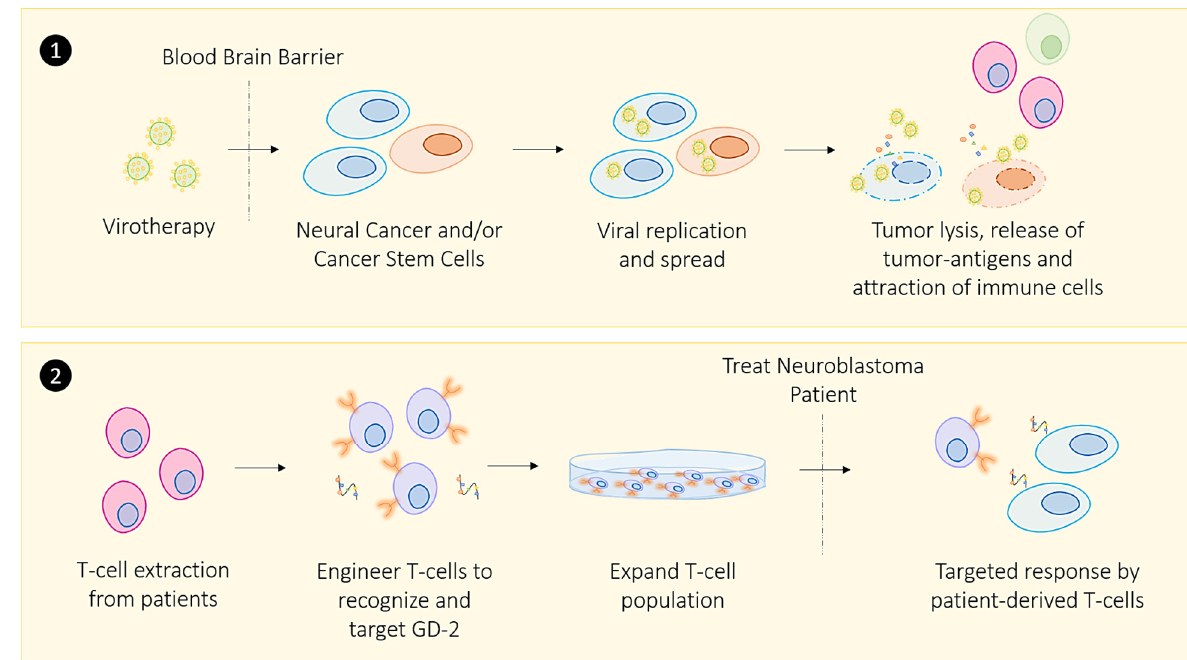
Figure 3. Neuroblastoma as a Study Model. Schematic representation of the virotherapy and targeted T cell therapeutic approach is applied to treat neuroblastoma. (1) Application of Zika virotherapy is engineered to target neural cancer and cancer stem cells to elicit an immune response targeting tumor-associated antigens’ release following virus-mediated cancer cell lysis. (2) Targeted CAR T cell therapy, where patient-derived T cells are engineered to recognize and target antigens exclusively expressed on neural cancer cells (i.e., GD-2) and target and clear cancer cells expressing this marker. Abbreviations: CAR T cells, chimeric antigen receptor T cells; GD-2, disialoganglioside.